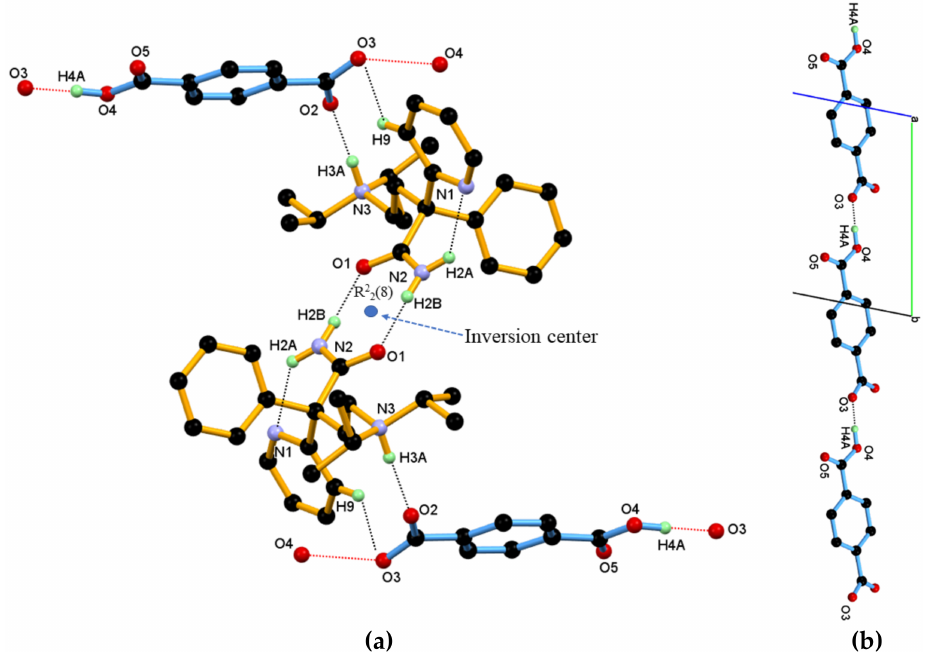
Figure 3. ( a ) Dimeric unit of DPA:TA salt. In this, the inversion center related asymmetric unit of DPA:TA extends through the N − H ··· O hydrogen bond in the R 2 2 (8) ring motif in ac -diagonally. ( b ) TA anion linked to neighboring unit translated TA anion through a strong and linear O4– H4A ··· O3 ¯ hydrogen bond to form a one-dimensional (1D) chain of TA anion alon the b -axis. Dotted lines indicate the non-covalent interaction (hydrogen atoms not involved in the hydrogen bonding were removed for clarity).